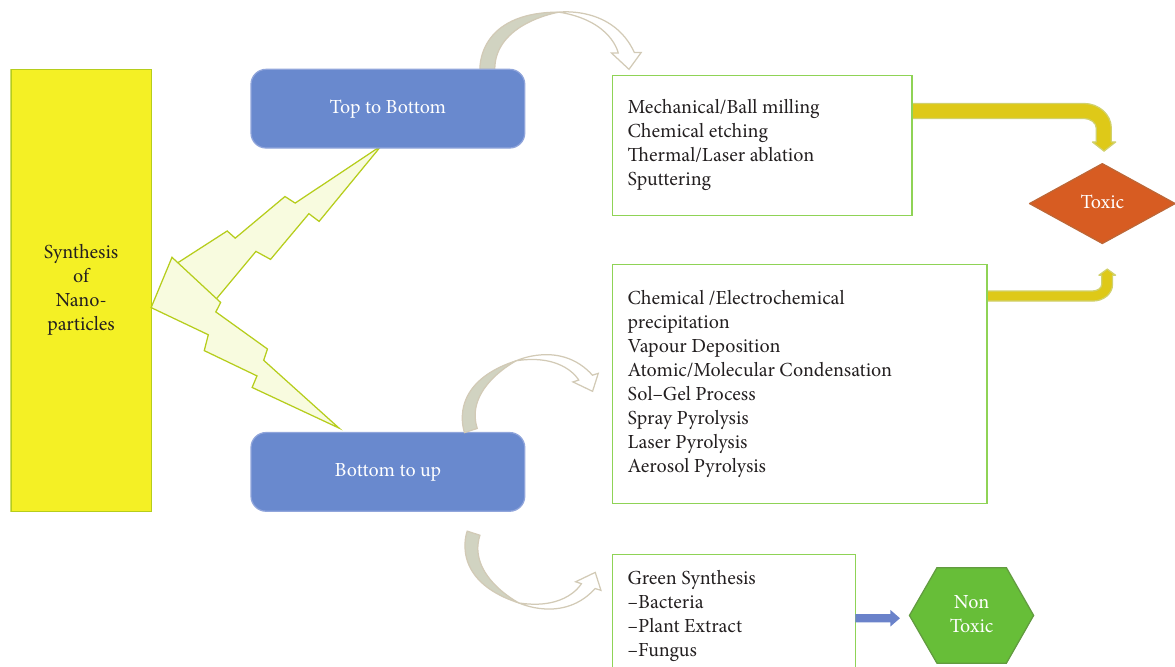
Figure 2: Various physical, chemical, and green approaches for the synthesis of NPs